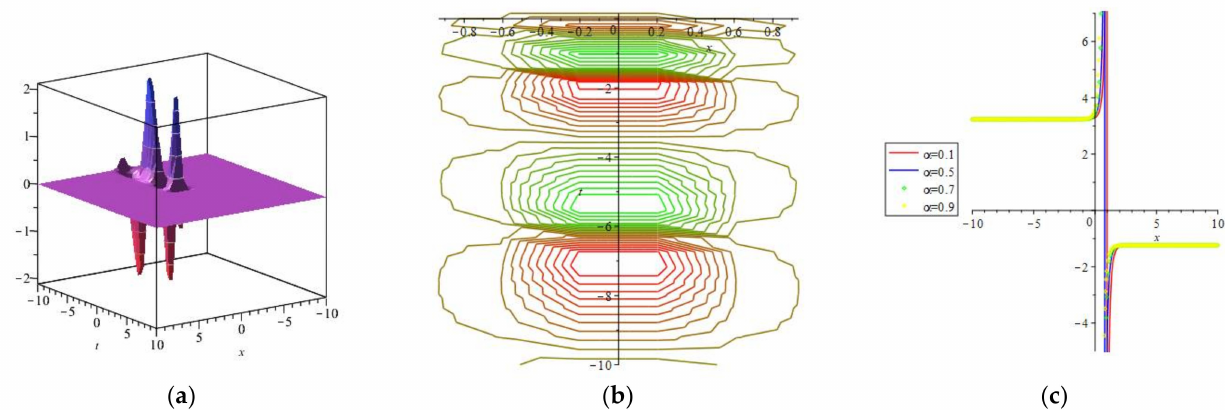
Figure 4. The graphical representation of the solution λ 31 ( χ ) : ( a ) 3D shape, ( b ) contour plot, and ( c ) 2D